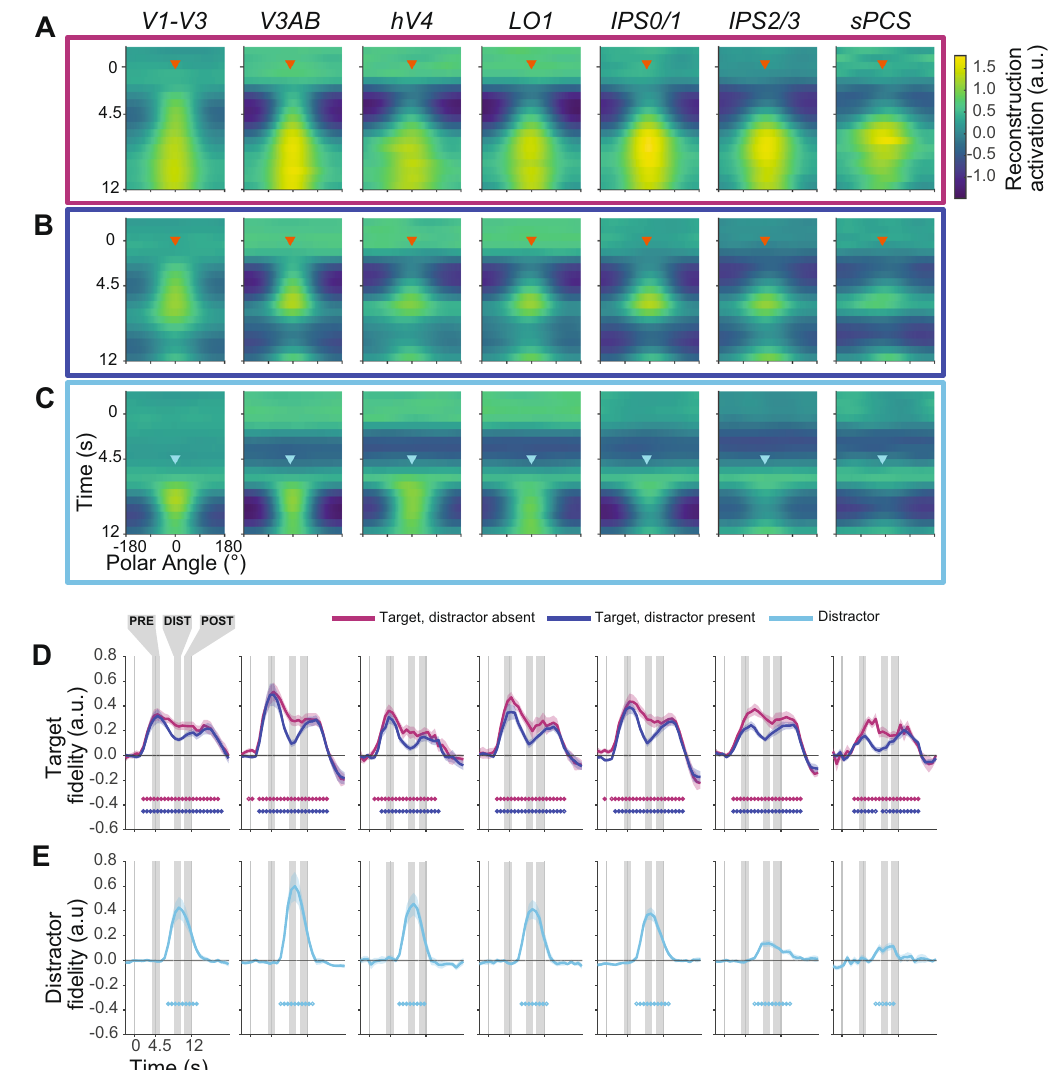
Fig. 4 Impact of distraction on the dynamics of WM representations. Average reconstruction of WM target locations on distractor-absent ( A ) and distractor-present trials ( B ) across all participants ( n = 7). c Reconstruction of distractor locations on distractor-present trials, where all trials were aligned to a fi xed distractor location. Note that B and C include the same data, just aligned to different locations (see Fig. 3). Reconstruction strength (arbitrary units, a.u.) is greatest at the aligned location in each instance and represents the polar angle location of the WM target maintained over the entire delay period or the brie fl y presented distractor. D , E Fidelity of the neural representation of WM targets ( D ) and distractors ( E ). When activation peaks in the direction of the remembered target (after alignment), fi delity is positive; when there is no consistent activation peak, fi delity is near zero. Target fi delity on distractor-absent trials is robust and statistically signi fi cant throughout the delay period in all ROIs. When the distractor is present, fi delity drops, but remains signi fi cantly above zero for all ROIs except for one 750ms TR in sPCS. Distractor fi delity is also statistically signi fi cant in all regions and is qualitatively most robust across extrastriate visual cortex (e.g., V3AB). Closed and open circles denote signi fi cance of p < 0.05, one-sided, FDR corrected and p < 0.05, one-sided, FDR uncorrected, respectively (one-sample t -test using null distribution derived from shuf fl ed IEM; see Methods section). Error bars stimulus across visual, parietal, and frontal cortex. To quantify remained above chance throughout the delay indicating accurate and test this hypothesis, we computed a fi delity metric 22,43,44 , and sustained WM target encoding (Fig. 4D). On distractor- which measures the strength of the representation within the present trials, we observed a phasic increase in fi delity values for reconstruction. Reconstructions of correct WM target locations the distractor location time-locked to the onset of the distractor in result in larger positive fi delity values, while poorly matched all ROIs (Fig. 4E). Moreover, the fi delity of the WM target reconstructions produce low values. Importantly, fi delity can be representation dropped in all ROIs in the time-points corre- computed independently for both the WM target and distractor sponding to the phasic distractor response (Fig. 4D). Nonetheless, locations because their relative locations were carefully counter- even during this dip in target fi delity, the values for the WM balanced and distributed (i.e., the average distractor location target remained signi fi cantly greater than zero indicating that relative to an aligned WM target location has a fi delity of zero). the population response still contained information about On distractor-absent trials, the fi delity values in all ROIs grew the WM target location (Fig. 4D, E, one-sided t -test at each signi fi cantly time-locked to the WM target presentation and timepoint compared against a null distribution computed with a